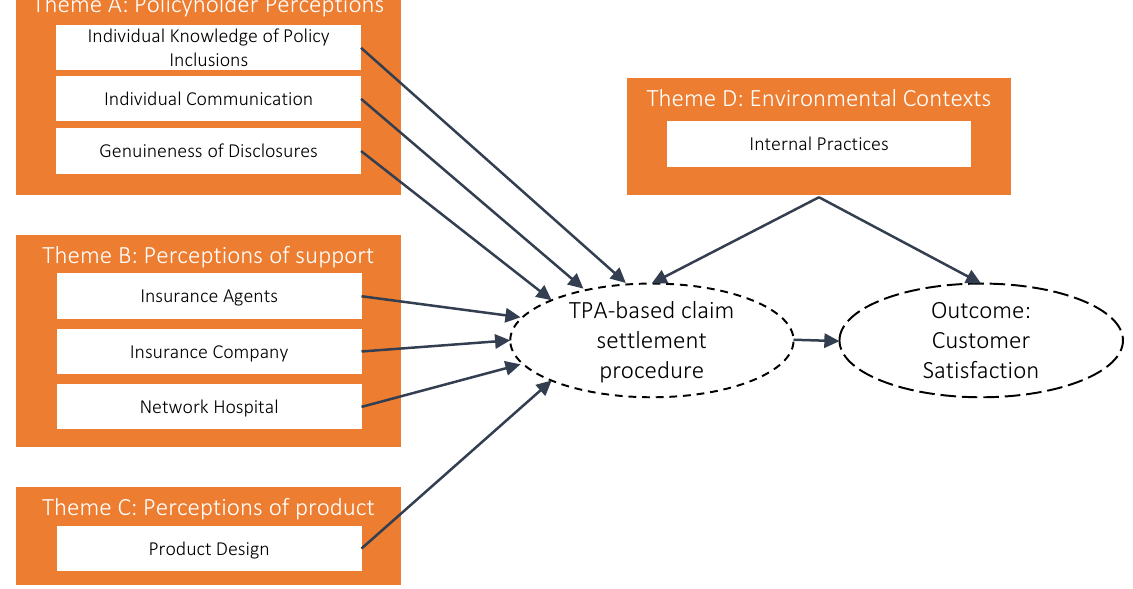
Figure 1. Proposed conceptual